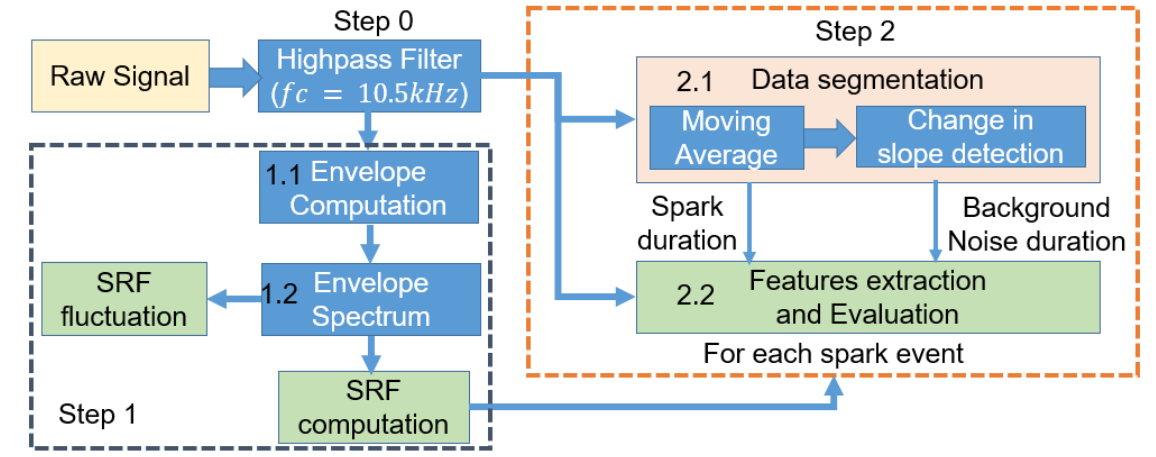
Figure 4. Flow chart of the employed methodology.